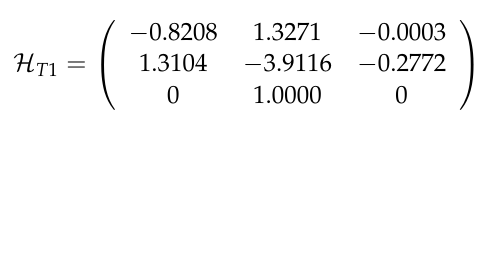
Table 2. Robustness Analysis Showing Different ranges of C Z Hydrodynamic